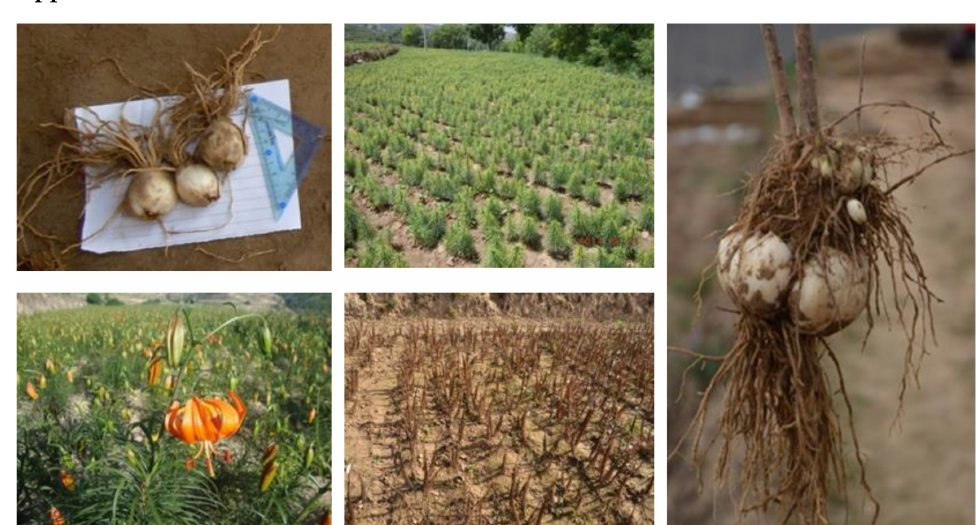
Figure A1. The Lanzhou lily cultivation methods: the sweet lily is cultivated perennially; after 3 years of cultivation, the large bulb (the mother bulb after three years of growth) is consumed as food, and the baby bulbs are resown to produce seed bulbs after 2–3 years of